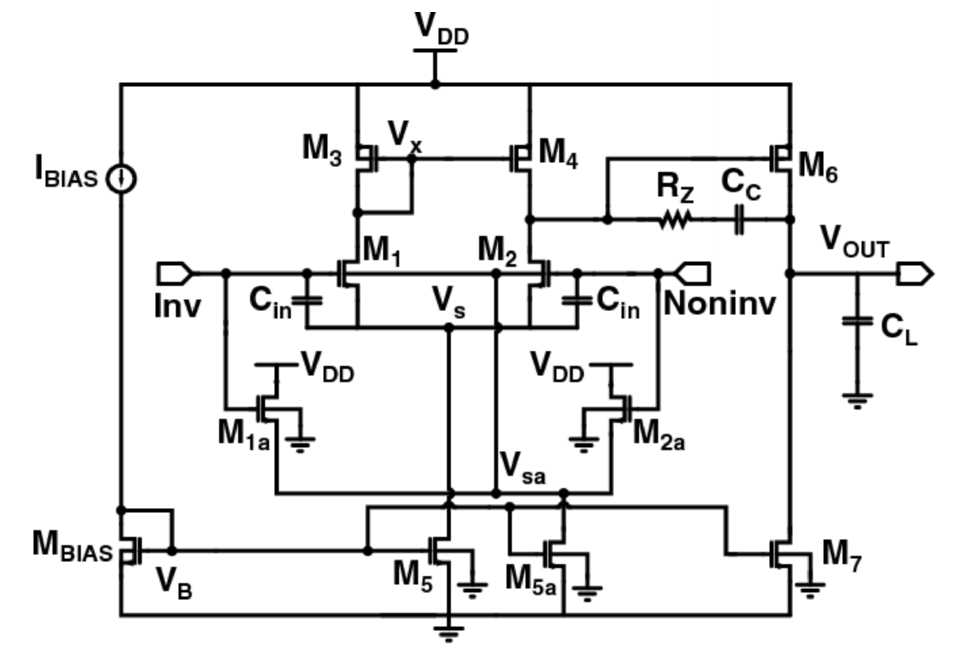
Figure 1. The source-buffered (SB) Miller amplifier proposed in [18]. Table 2. Transistors’ aspect ratios (W/L) [ µ m] in the Miller architectures.